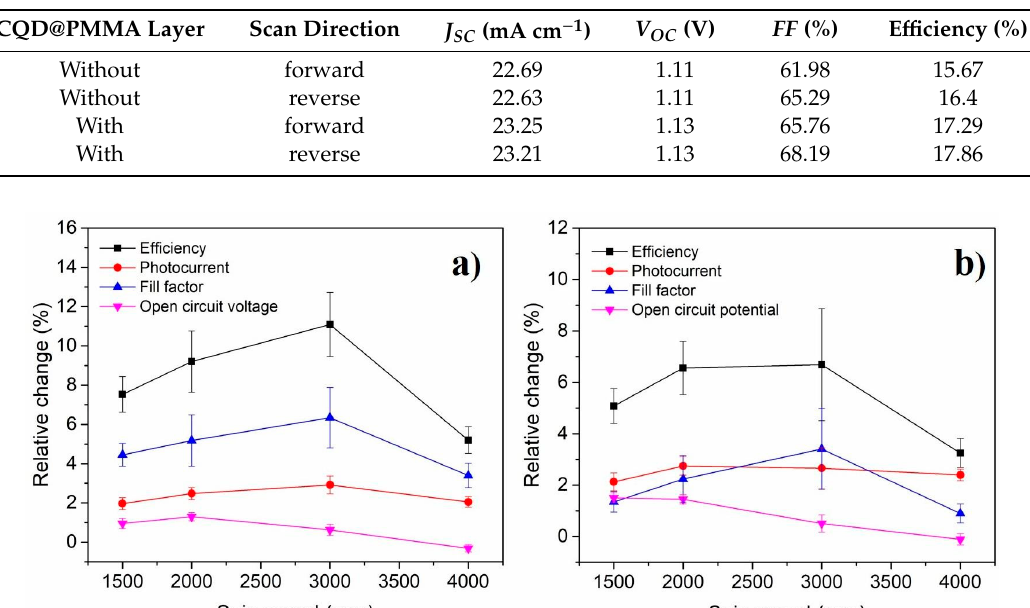
Table 1. Photovoltaic parameters for a PSC device before and after application of a CQD@PMMA layer tested under 1 sun illumination.